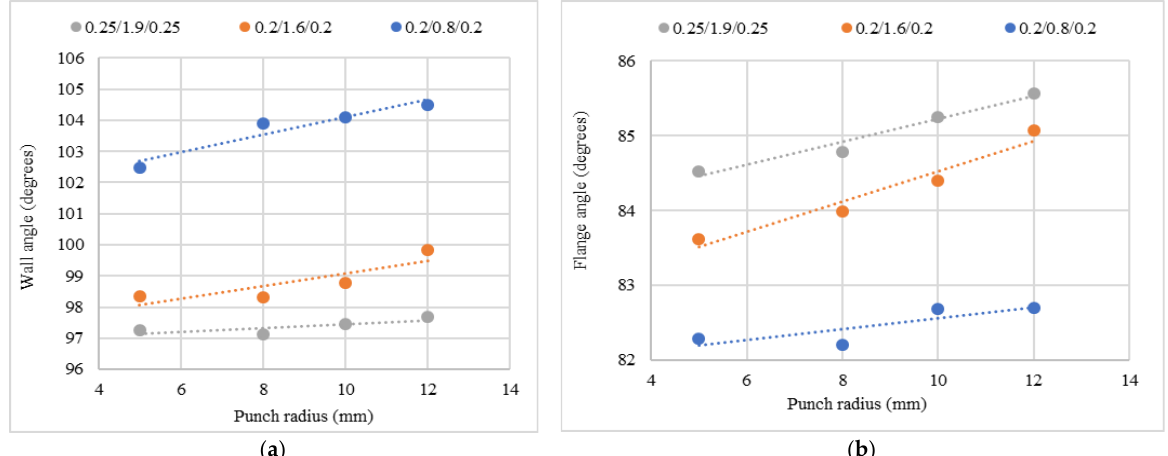
Figure 13. ( a ) Effect of punch radius on wall angle after springback and ( b ) Effect of punch radius on flange angle for three different sandwich laminate thickness combinations and a constant die radius of 8